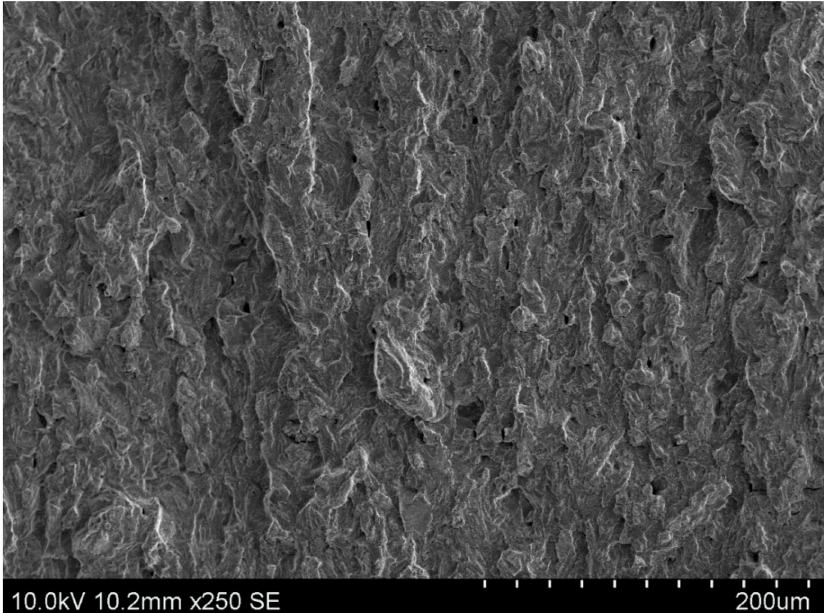
Figure 10. Initial fatigue crack path (15 mm) of the tested specimen with stop hole ( ∆ K = 24 MPa × m 0.5 ), crack growth direction from bottom to top.